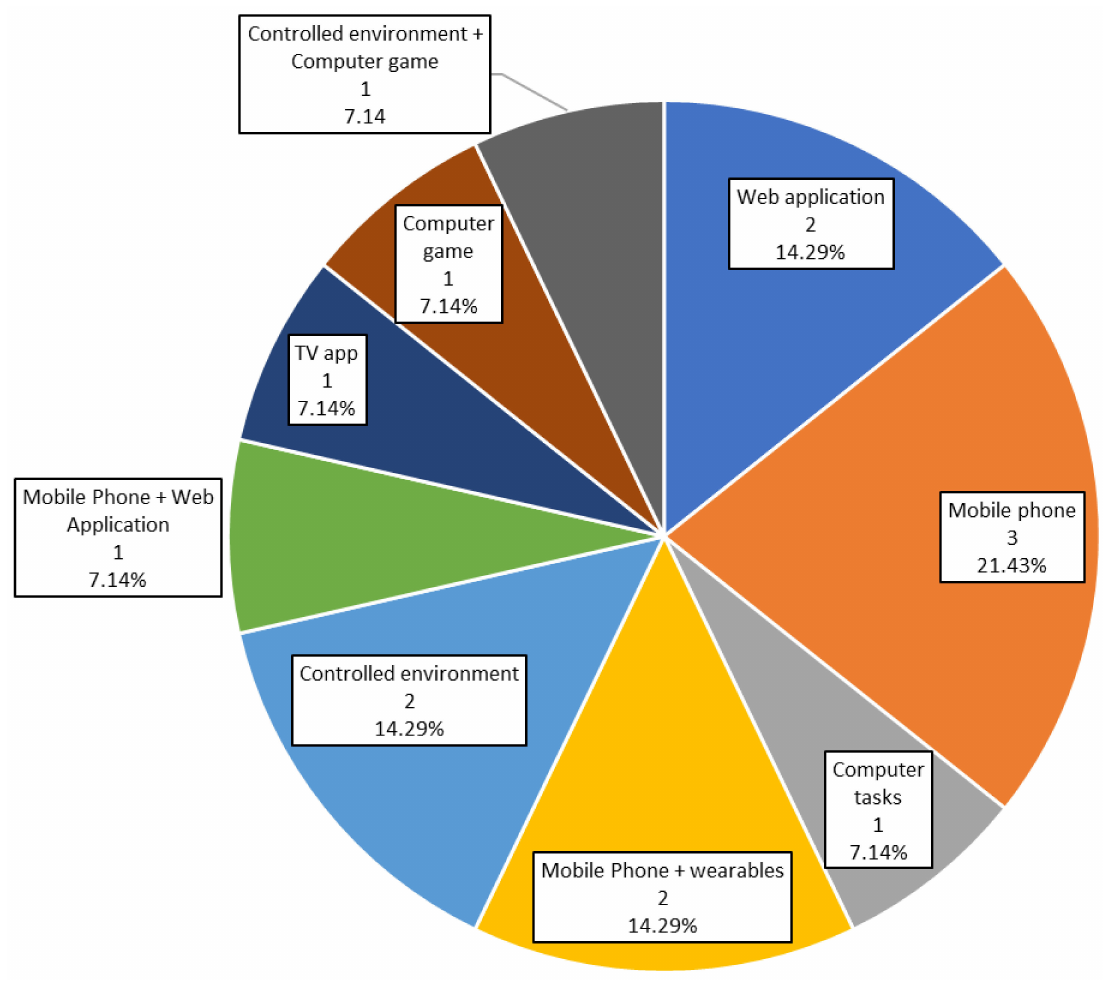
Figure 5. Technologies results. Percentage of studies in each